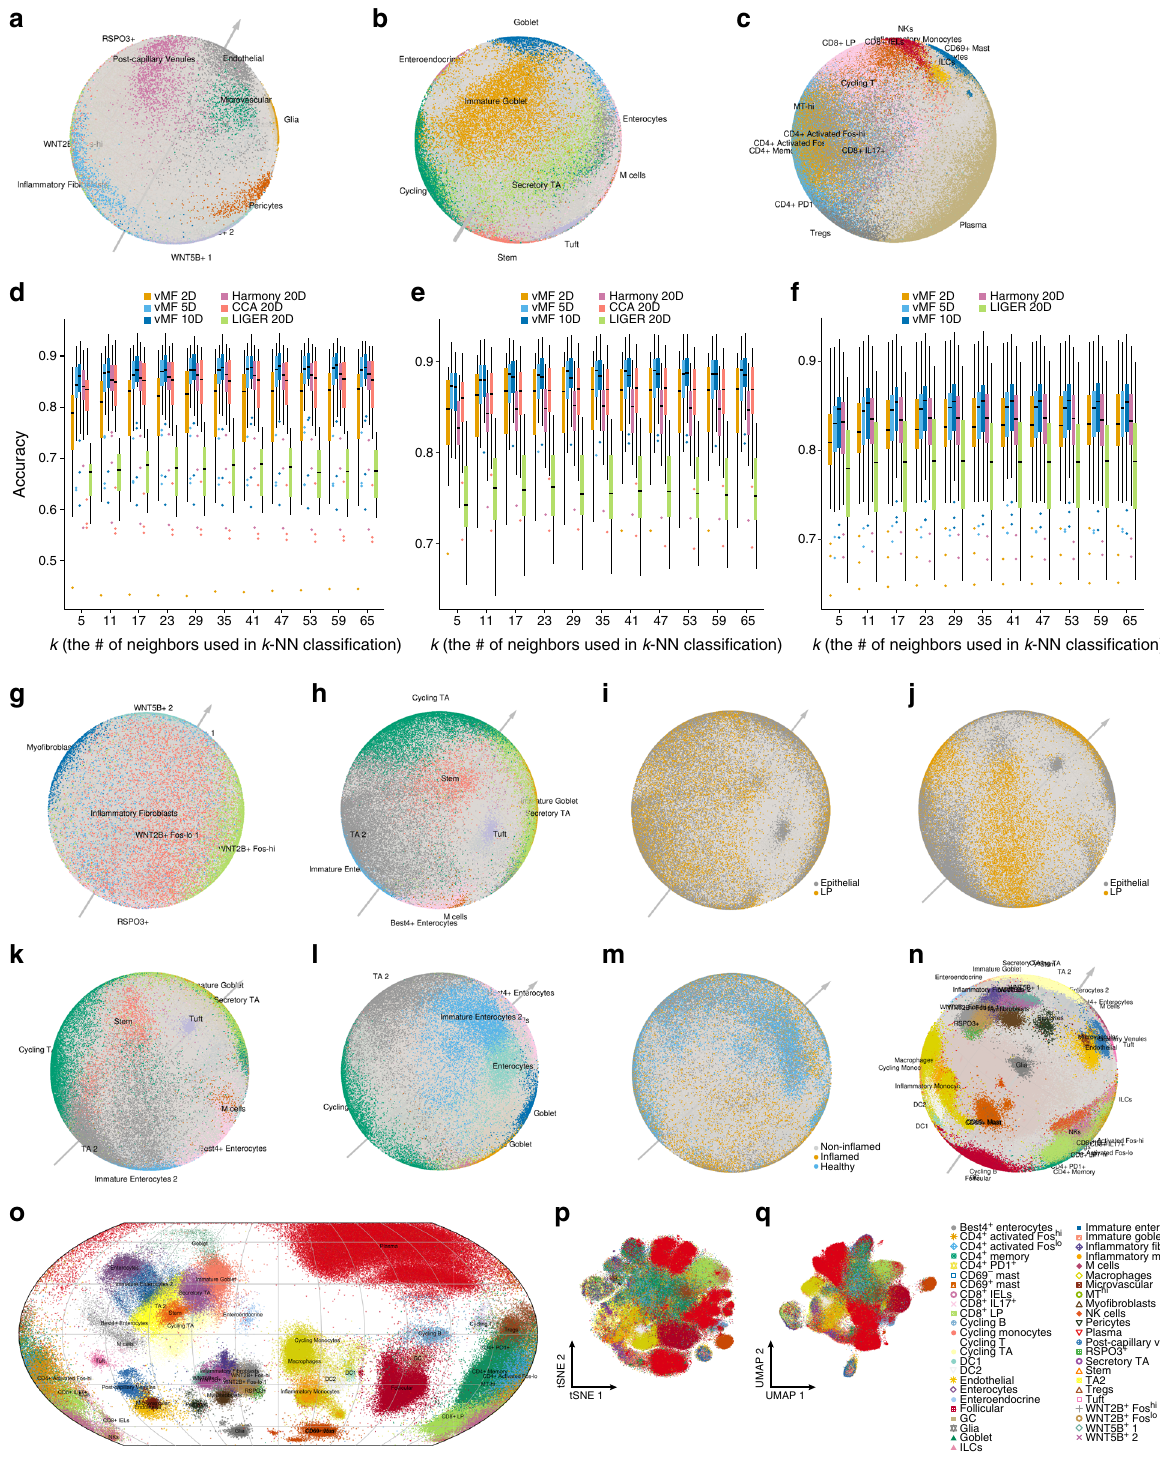
dimensions, comparing the k -NN classi fi cation accuracy of scPhere with hypersphere embedding to a standard normal prior and normal posteriors, which embeds cells in a Euclidean latent space, as well as to t -SNE, UMAP, and PHATE (holding out cells from one patient at a time for testing). We used the UC dataset, for each of the three major cell compartments separately, with the labels from the original study 33 . For t -SNE, UMAP, and PHATE, we used 20D or 50D Harmony batch-corrected principal com- ponents (PCs) (as Harmony can correct multilevel batch effects